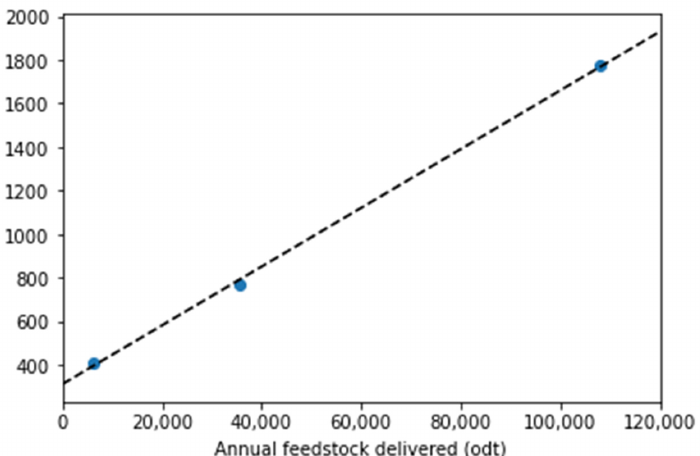
Figure A1. Plot of annual pre-treatment costs versus feedstock delivered for biomass pyrolysis preparation. The values were taken from Bridgwater et al. [13].